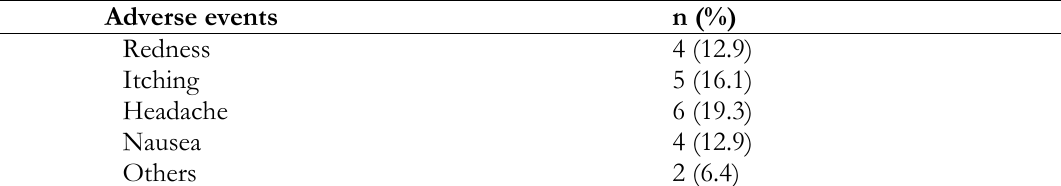
Table III. Numbers of participants reporting adverse reaction events